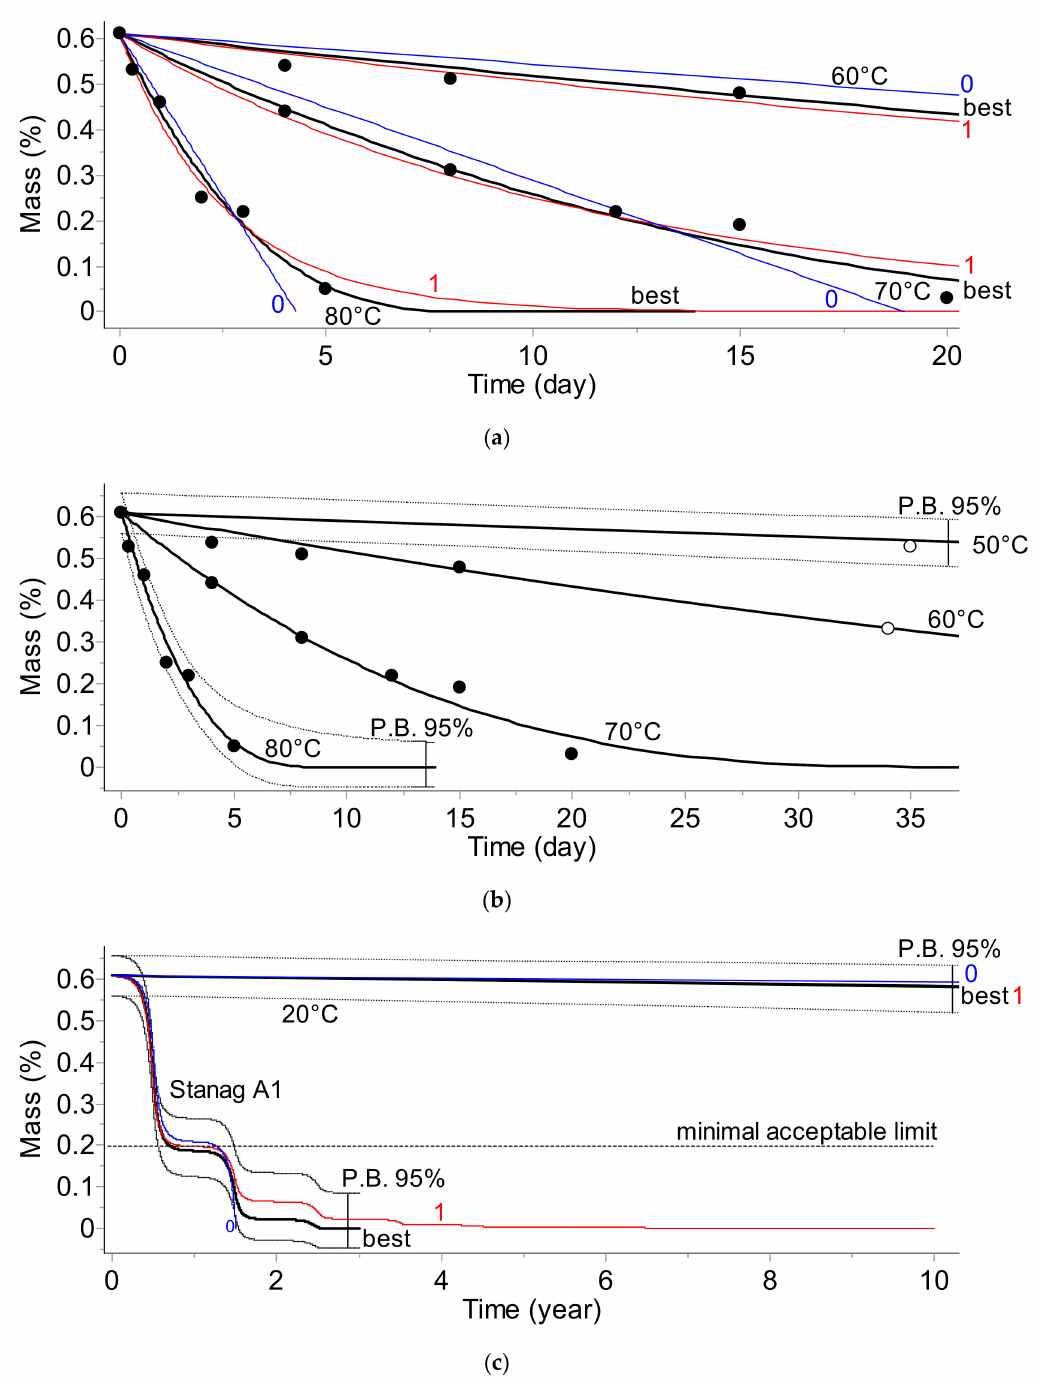
Figure 3. Stabilizer depletion (UPLC) test. ( a ) The fit of experimental data by the best (bold), 0th, and 1st order models. ( b ) Prediction of the long-term reaction course for temperatures of 80, 70, 60, and 50 ◦ C (predictions are verified by experimental data marked as empty circles). ( c ) 10-year predictions for 20 ◦ C and climate category STANAG